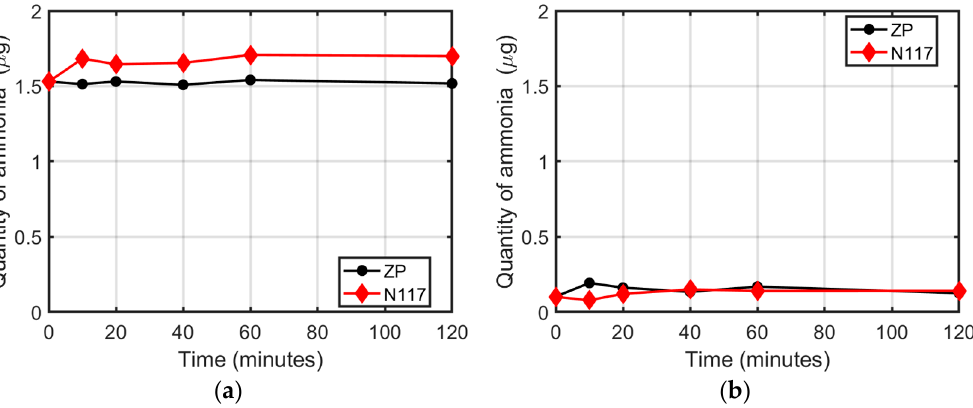
Figure 2. Ammonia quantity as a function of immersion time: ( a ) in the ammoniated electrolyte solution (0.1 Na 2 SO 4 + 0.1 ppm NH 4 Cl) with N117 or ZP; ( b ) in a 0.1 M Na 2 SO 4 solution after the immersion of N117 or ZP previously tested.